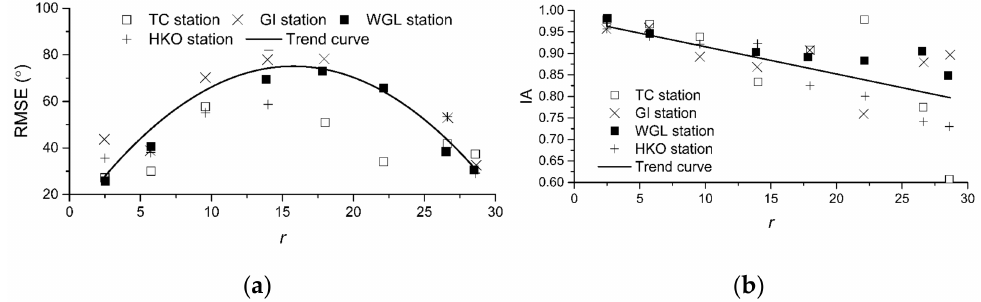
Figure 9. Wind direction error variation as a function of the r. ( a ) RMSE of wind direction; ( b ) IA of wind